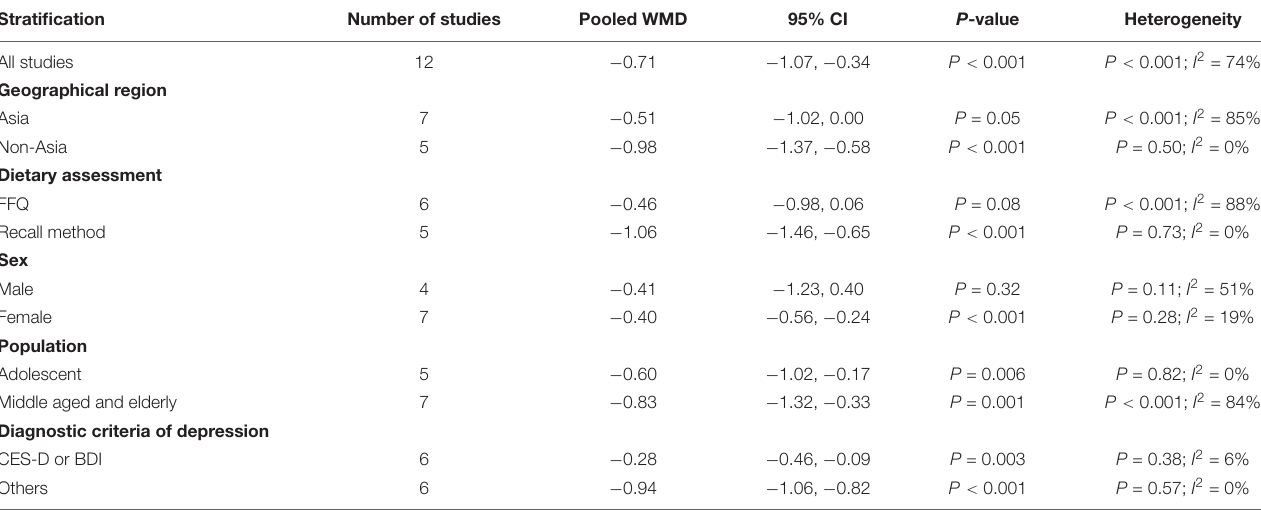
FIGURE 5 | Forest plot of meta-analysis: WMD of dietary vitamin E intake for depression versus control subjects. TABLE 5 | Subgroup analysis for WMD of dietary vitamin E level in depression versus control